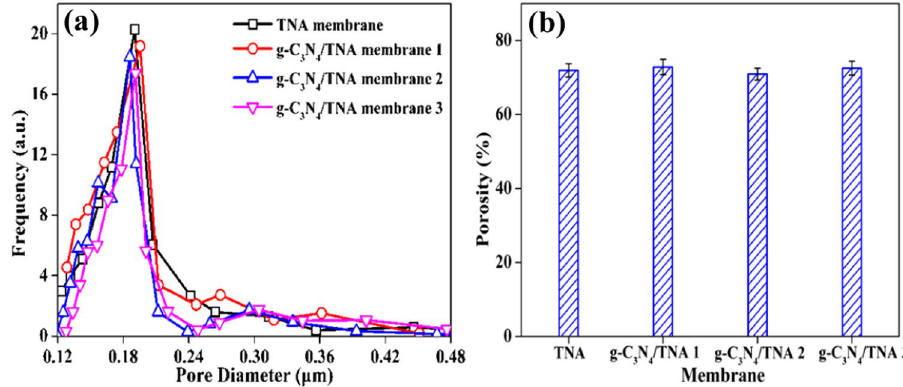
Figure 2. ( a ) Pore size distribution and ( b ) porosity changes of TNA membrane, g-C 3 N 4 /TNA membrane 1, 2 and 3.